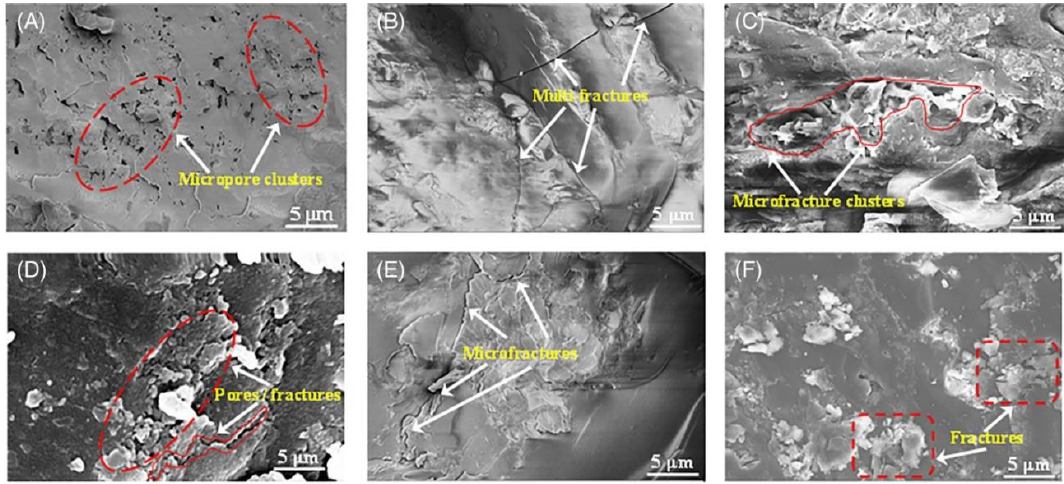
Figure 19. SEM images of surface morphology for studied samples [47].